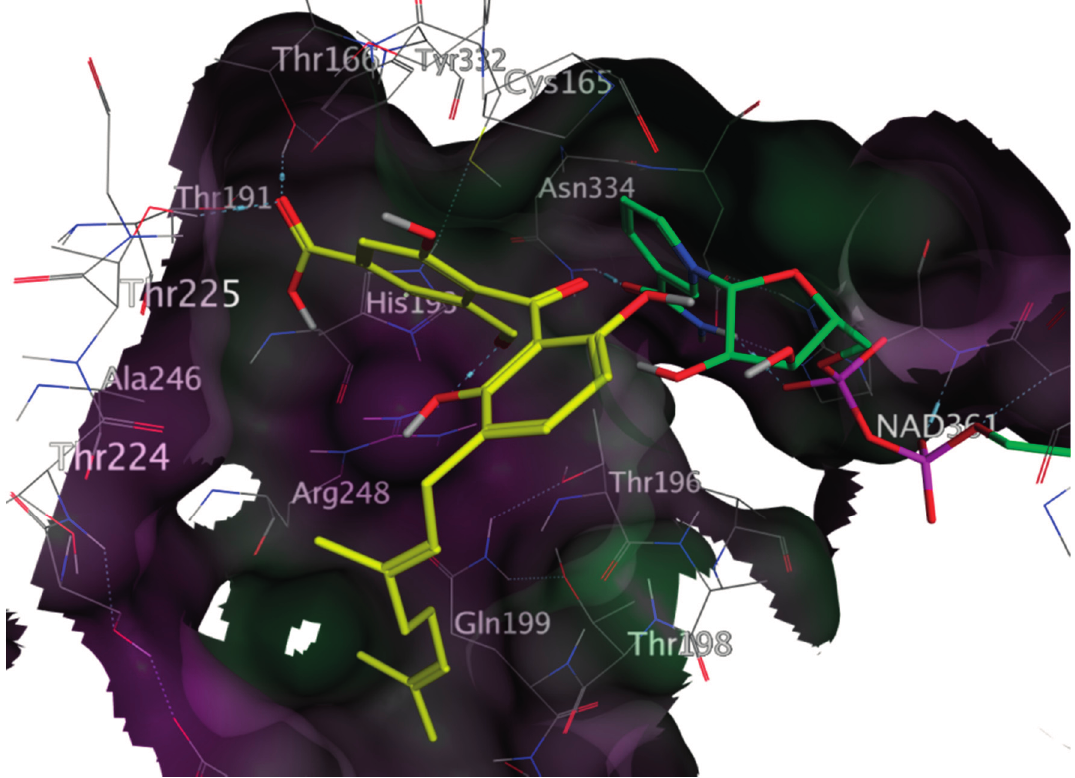
Figure 3. Lowest energy docking pose of compound NP-013296 ( 2 ) (yellow) in the G-3-P site of Tb GAPDH (PDB-ID 2X0N), NAD + shown with green carbon atoms;